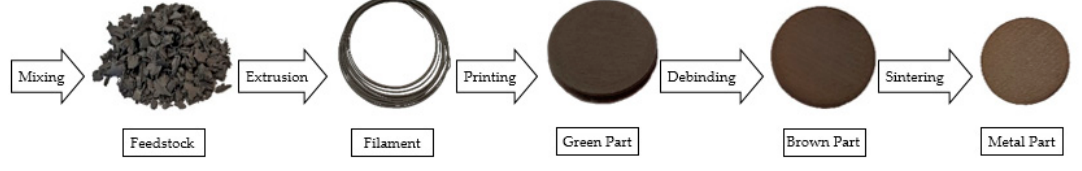
Figure 6. Workflow of fused filament fabrication.